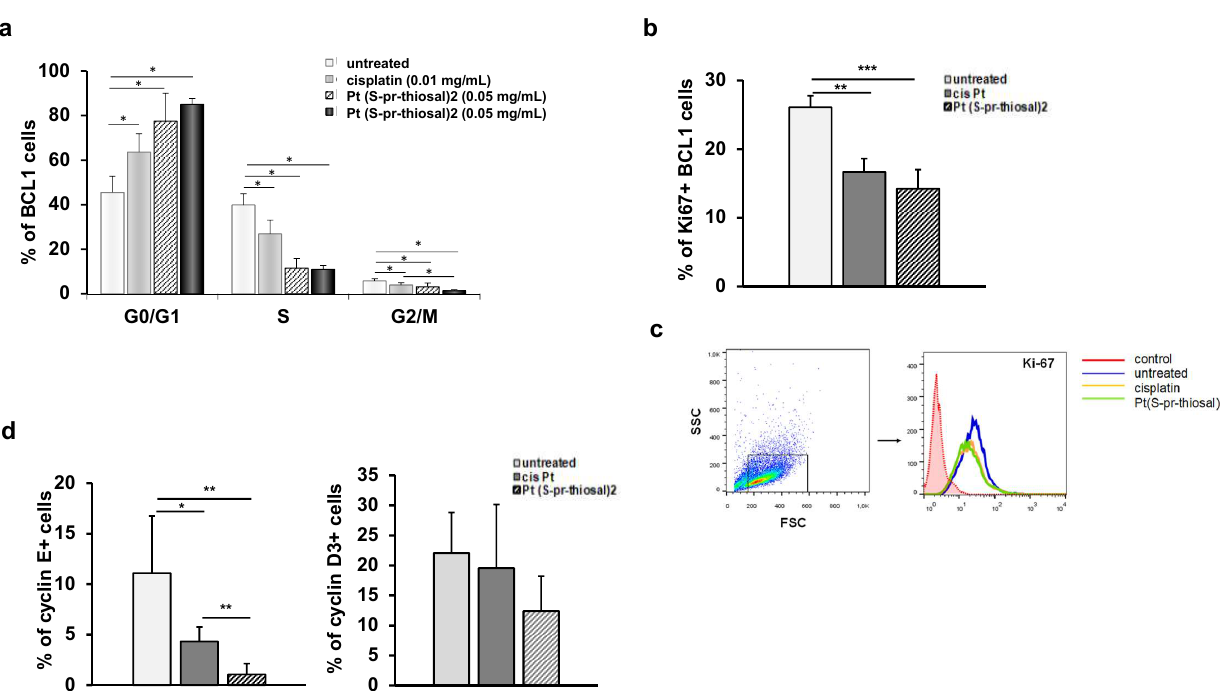
Figure 4. Pt( S -pr-thiosal)2 has antiproliferative effect on BCL1 cells. ( a ) The graph shows the mean percentage of BCL1 cells by phases of the cell cycle + SD; ( b ) Percentage of Ki67+ BCL1 cells + SD; ( c ) Representative histograms show Ki-67 expression in untreated, cisplatin-treated and Pt( S -pr- thiosal)2 treated BCL1 cells. ( d ) Percentage of cyclin E+ and cyclin D3+ BCL1 cells + SD from three independent experiments, for 3 replicates. Statistical significance was determined by Student’s t test, * p < 0.05, ** p < 0.01, *** p < 0.001. ( d ) representative histograms show Ki-67 expression in untreated, cisplatin-treated and Pt( S -pr-thiosal)2 treated BCL1